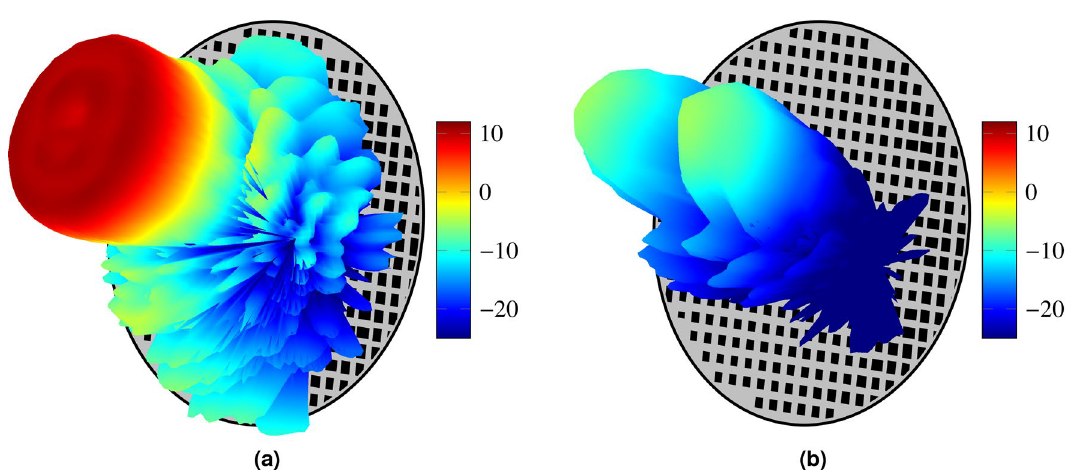
Figure 12. 3D representation of the ( a ) copolar and ( b ) crosspolar patterns for polarization